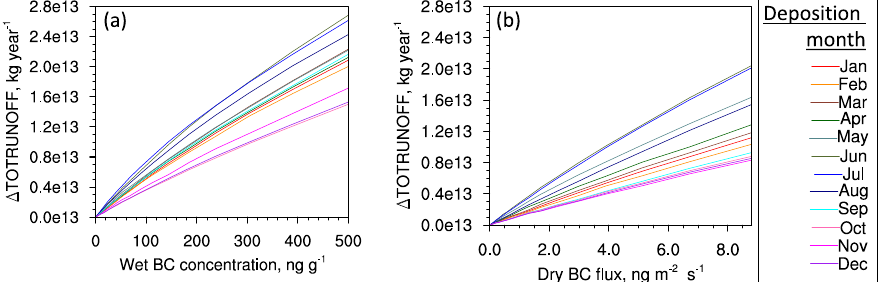
Figure 13. Increase in total Greenland runoff resulting from BC deposition integrated over 1 year starting from the month of BC deposition vs. concentration of BC in precipitation (a) and vs. BC dry deposition flux (b) . The runoff values are summed over the Greenland region and averaged over 10 1-year simulations beginning in the years 2006–2015. Different line colors represent different deposition